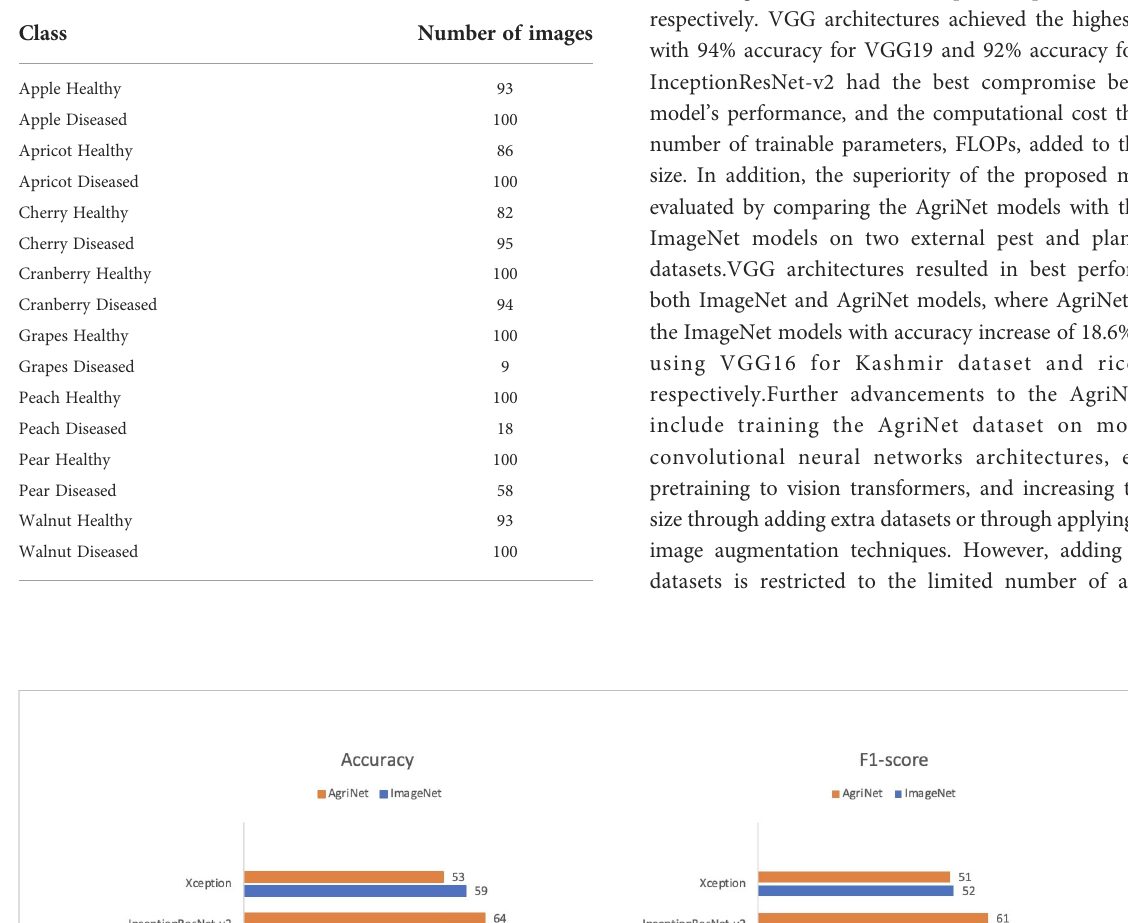
TABLE 11 Plant diseases of kashmir dataset description.